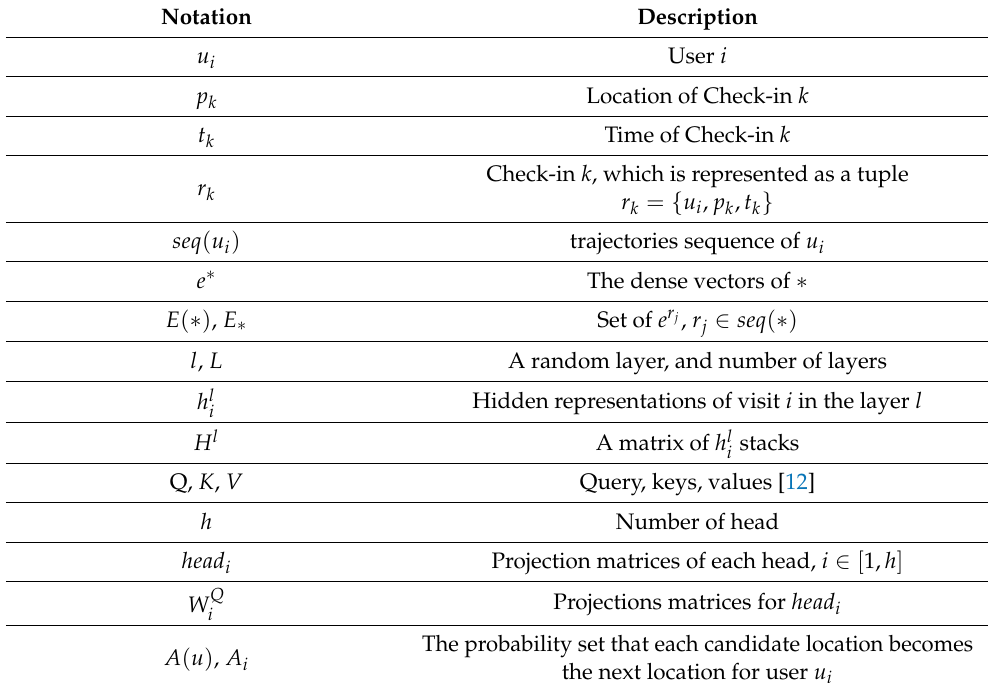
Table 1. Table of main